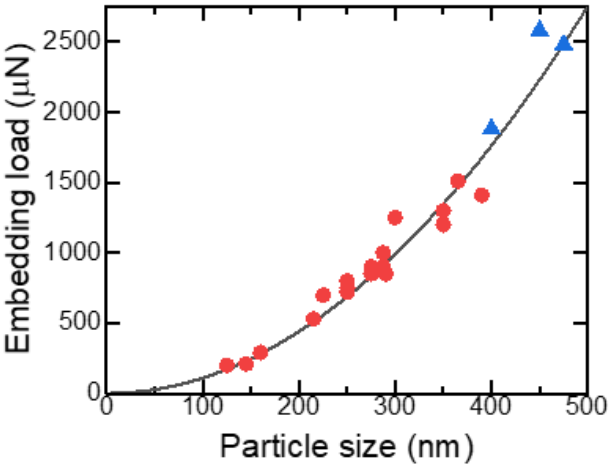
Figure 12. Particle size dependence of embedding load at the plateau region for B 4 C particles on Si substrate. Red circles and blue triangles are experimental data without and with pop-in behavior during indentation. The black curve is a fitted curve.